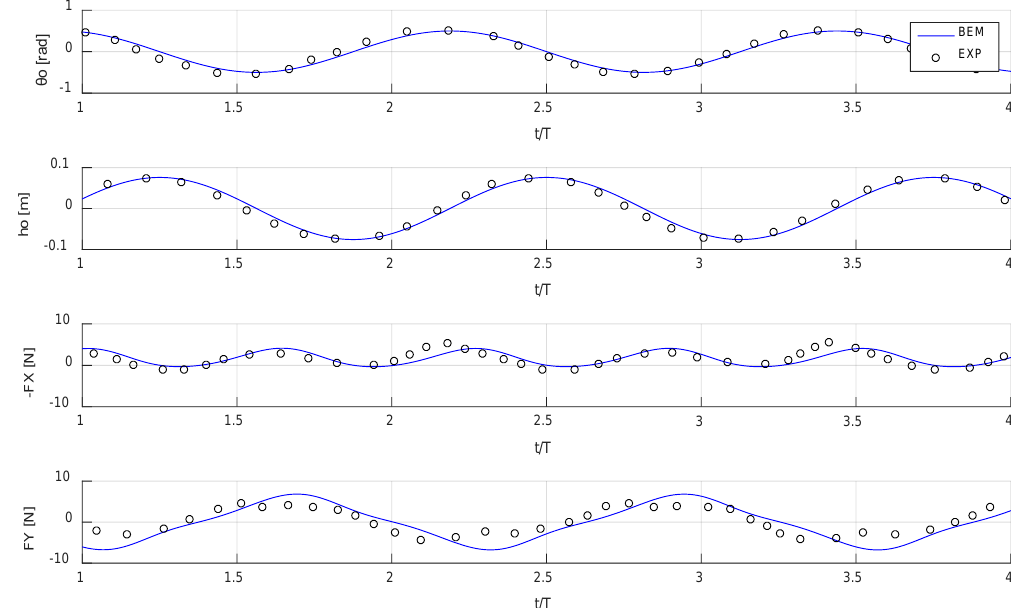
Figure 10. Time history of foil pitch and heave against thrust and lift forces for chordwise flexible foil with simple harmonic motion profile and comparison with the experimental data from [32]. ( a ) Pitch angle, ( b ) Heave, ( c ) Horizontal force, ( d ) Vertical force of the foil.